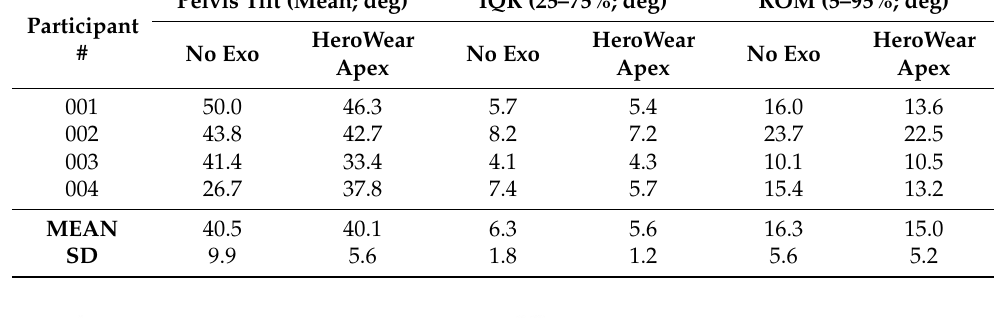
Table 2. Pelvis tilt (deg) for pushing the loaded gondola uphill.